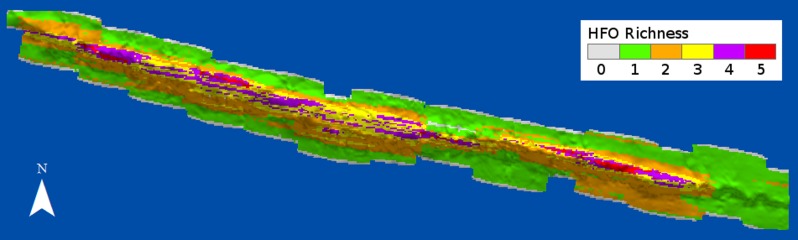
Richness of habitat-forming organisms (HFO) in Madagascar reef, Gulf of Mexico.The calculation considers the coexistence of macroalgae, octocorals, sponges, zoantharians and Millepora alcicornis.